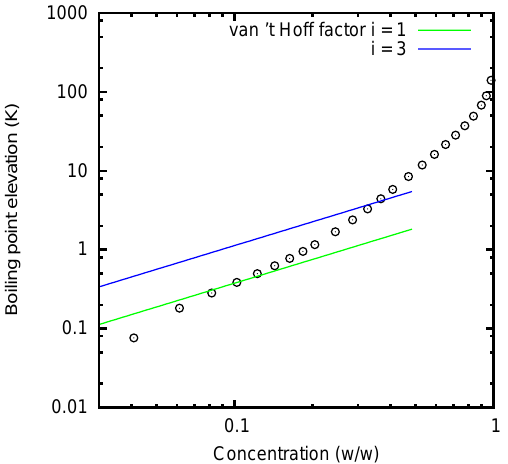
Figure 4. Boiling point elevation of the ZnCl solutions at 1 atm pressure. Data kindly 2 provided by Italshell [50], obtained by calculation. Some of the values have been also experimentally tested. The concentration is expressed as the ratio between the mass of the solute and the total mass of the solution. The lines are the linear approximation for dilute solutions, for two different values of the van’t Hoff factor. The actual boiling point elevation has an evident deviation from the ideal solution, also at low concentrations. A quite high boiling temperature is observed in concentrated solutions.